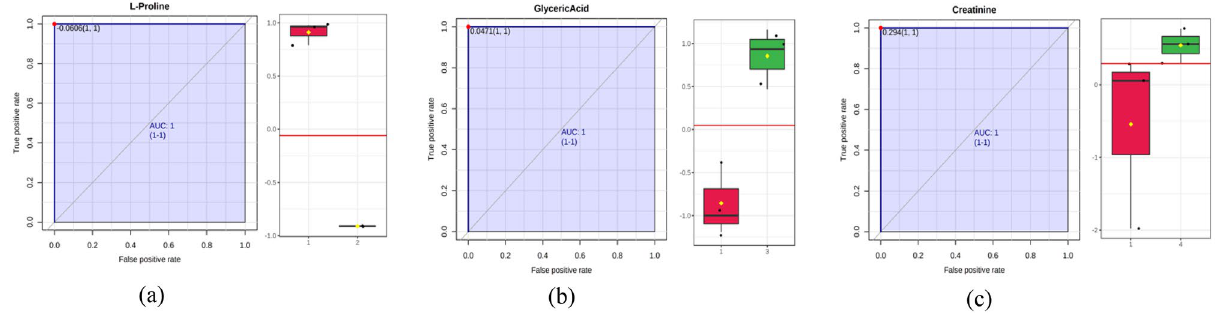
Figure 4. ROC curve and boxplot of ( a ) L-proline, ( b ) glyceric acid, and ( c ) creatinine as candidate biomarker compounds for Indices 2, 3, and 4, respectively.